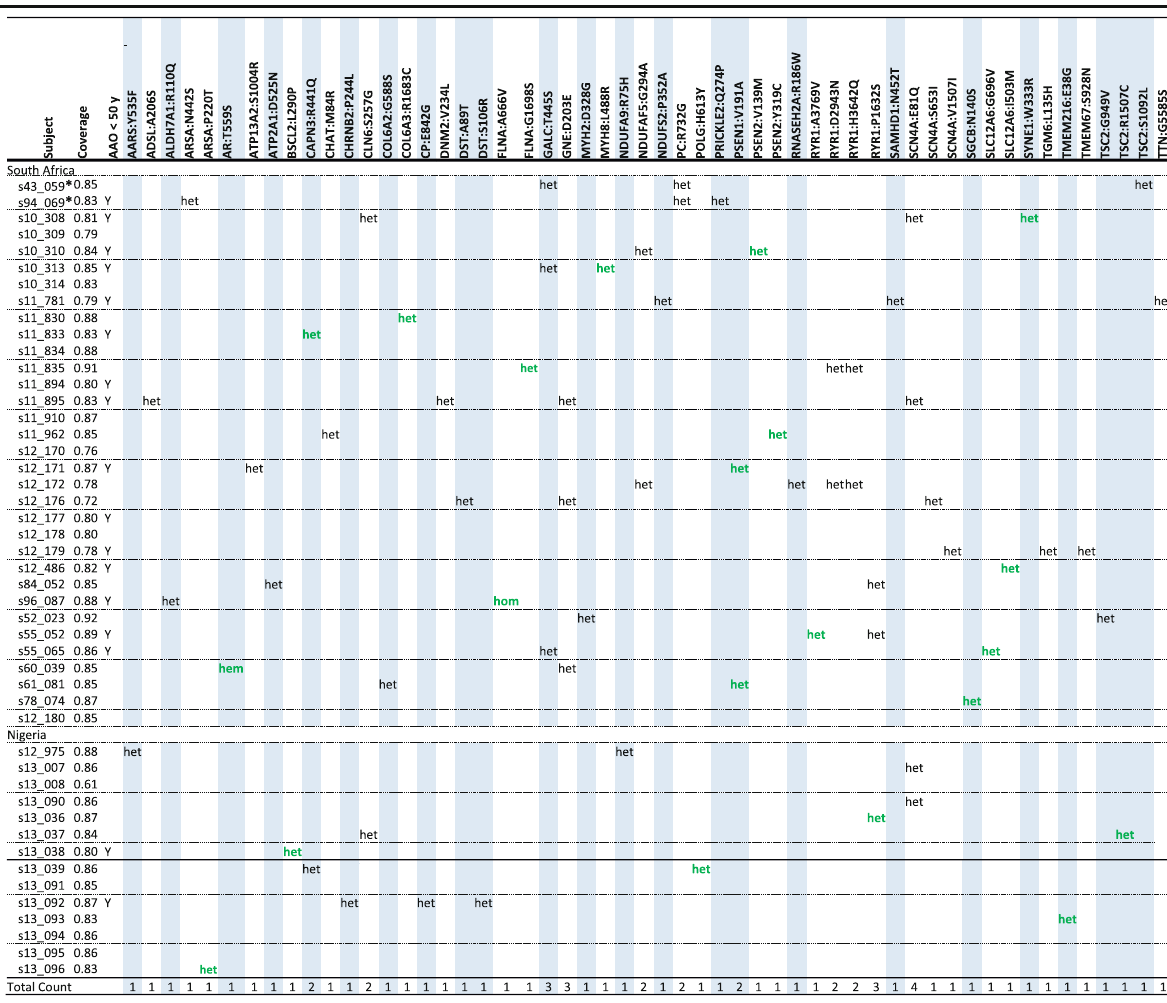
Table 3 Rare deleterious variants identified in the study